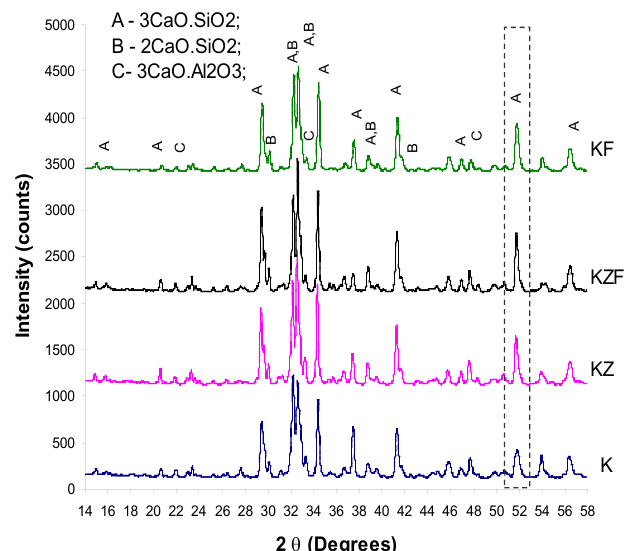
Figure 4. The XRD spectra of materials obtained by thermal treatment at 1350°C for 30 minutes.